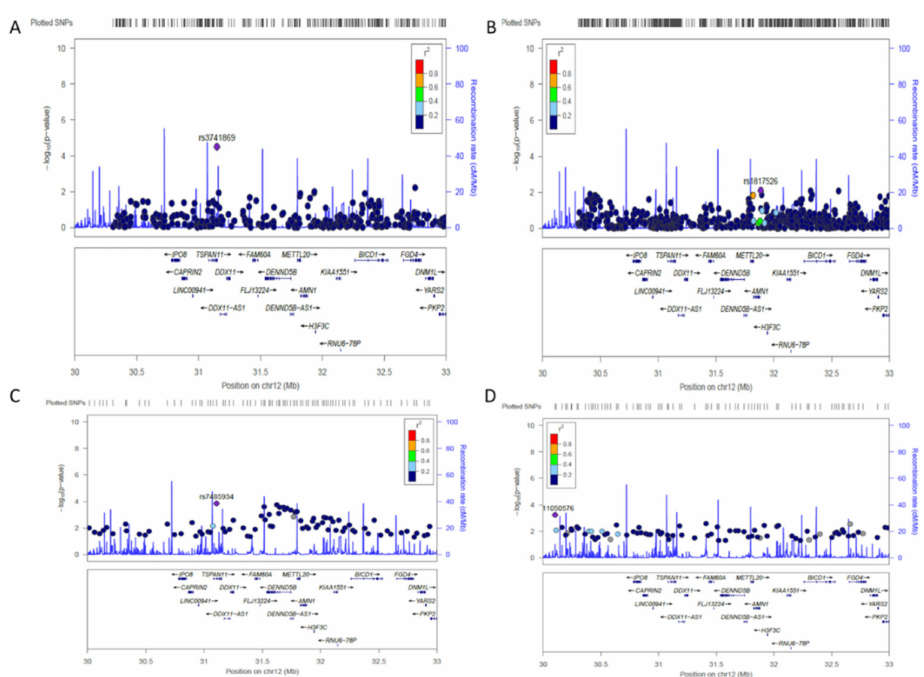
Figure 1. LocusZoom plot of genetic association at locus 12p11.21. ( A ) Association plot of all SNPs genotyped in GWAS db1 at the 12p11.21 locus. There are 60 genes at this locus. ( B ) LocusZoom plot of all SNPs genotyped in GWAS db2 at the 12p11.21 locus. ( C ) OASIS analysis identified the most significant SNPs in 20 kb window size which were plotted for db3 using LocusZoom. ( D ) Plot of the most significant SNPs in db4.